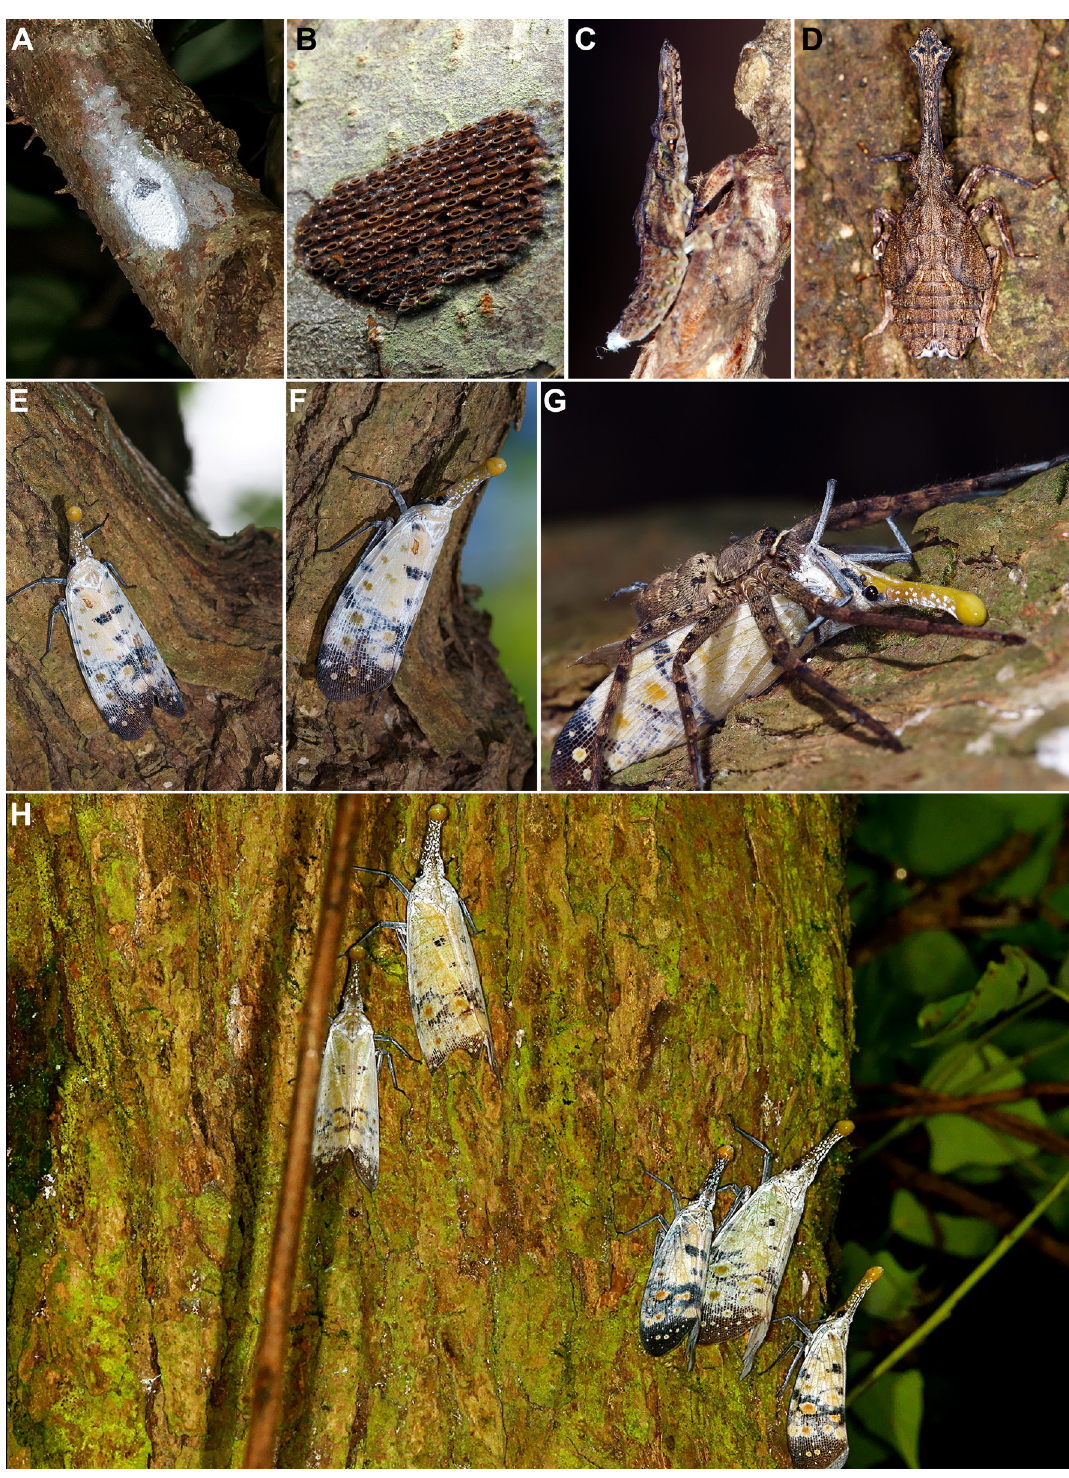
Fig. 22. Pyrops watanabei (Matsumura, 1913) in nature (photographs by S. Chen). A . Eggs, Taipei City, 28 Jul. 2012. B . Hatched eggs, idem, 19 Feb. 2016. C . Nymph, Nantou County, 14 Feb. 2012. D . Nymph, Taipei City, 7 Jun. 2012, on Triadica sebifera (L.). E–F . Adult, Taipei City, 16 Aug. 2012, on T. sebifera . G . Adult predated by a Sparassidae spider, Taipei City, 16 Aug. 2012, on T. sebifera . H . Group of adults, Taipei City, 6 Aug. 2011, on trunk of T. sebifera